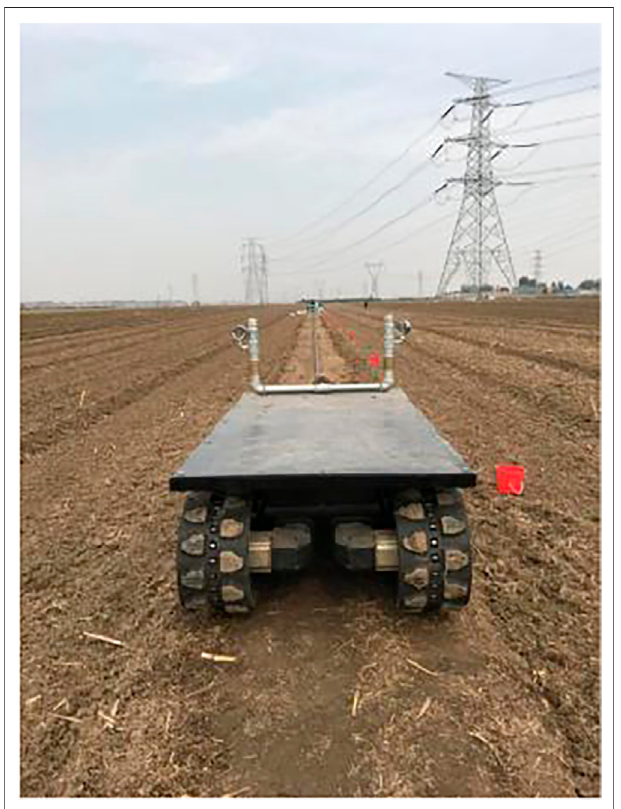
FIGURE 7 | The test process of dragging the tube with water.